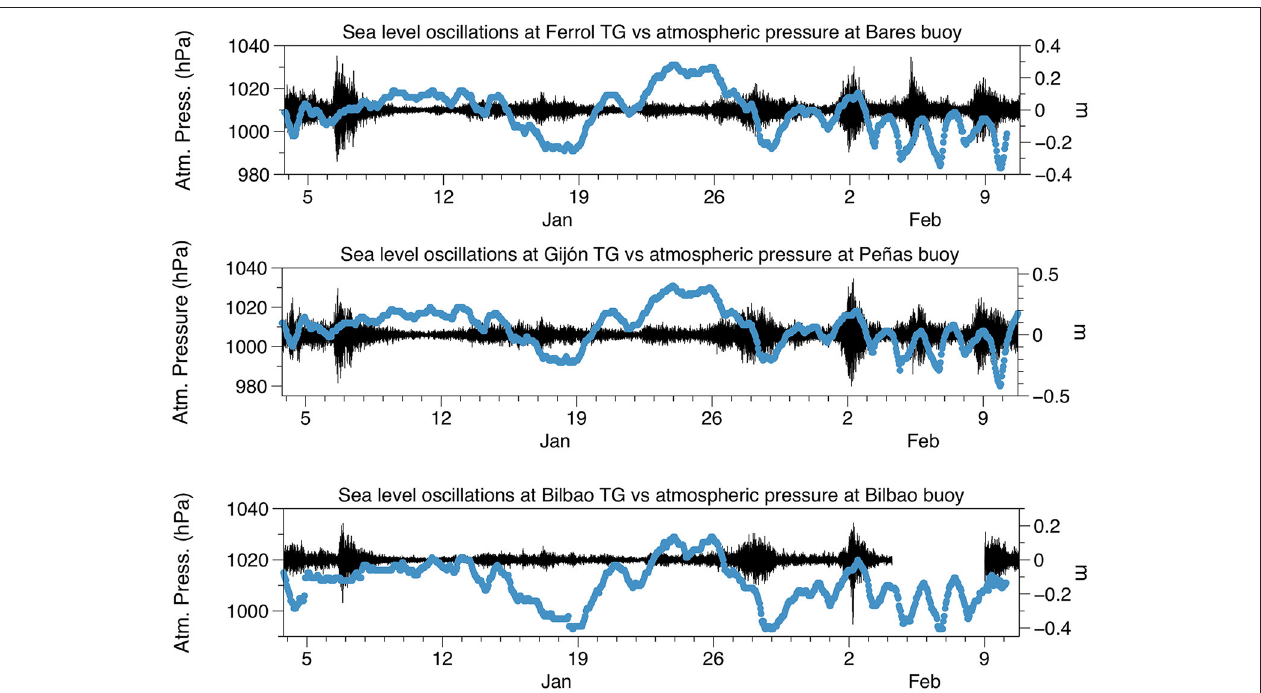
FIGURE 6 | Sea level oscillations at Ferrol, Gijón, and Bilbao tide gauges for January–February 2014 (black lines), and atmospheric pressure recorded by the nearest deep water buoy (blue lines: Bares, Peñas, and Bilbao, respectively). Data sampling for sea level oscillations is 1min, data sampling for atmospheric pressure recorded by buoys is 1h.